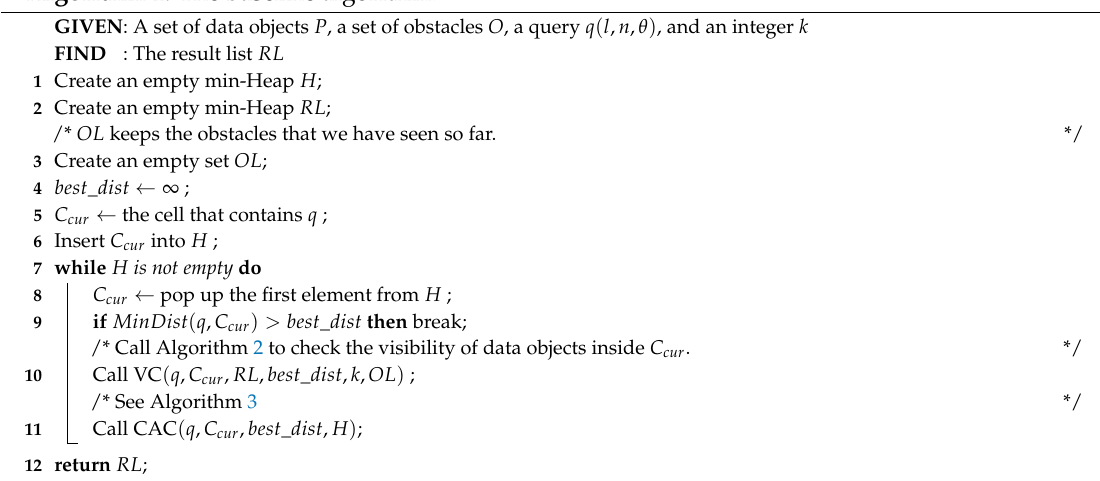
Algorithm 1. The baseline algorithm.